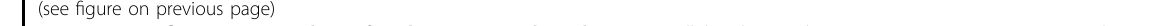
Fig. 8 Immuno fl uorescence analysis of 3D brain organoids at day 70. A Cellular identity characterization in FMRP-WT (top) and FMRP-KO (bottom) brain organoids. Immunostaining at day 70 revealed the presence of cells positive for pan-neuronal marker MAP2 (red) and GFAP expressing astrocytes (green). Nuclei were stained with DAPI (blue). Scale bar: 500 μ m. B Higher magni fi cation of representative GFAP-positive regions within FMRP-WT (top) and FMRP-KO (bottom) brain organoids at day 70. Scale bar: 20 μ m. C Bar charts showing the fl uorescence intensity quanti fi cation of MAP2 signal ( p = 0.84, MW test) and GFAP signals (** p < 0.01; WT n = 42/7/2, KO n = 29/6/2, slices/organoids/batches). D Scatter plot of astrocyte density in FMRP-WT ( n = 49/18/8/2, FOVs/slices/organoids/batches) and FMRP-KO brain organoids ( n = 45/11/5/2, FOVs/slices/ organoids/batches) at day 70 (** p < 0.01, MW